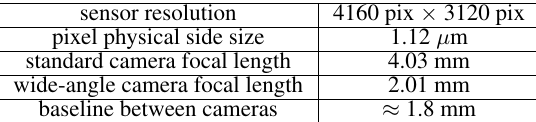
Table 2. LG G6 characteristics)